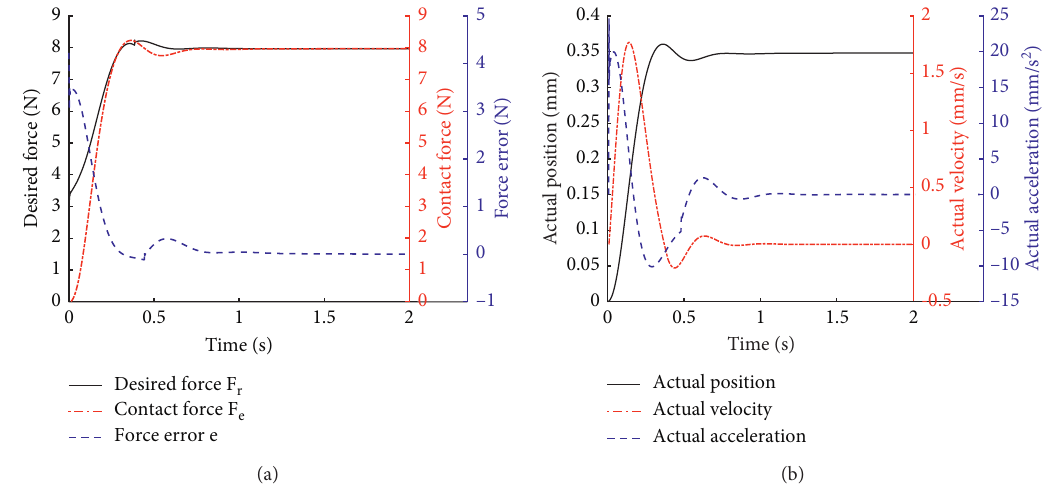
Figure 15: Simulation results of grasping force control with fixed parameter impedance control. (a) Curves of desired force, contact force, and force error varying with time. (b) Curves of actual position, velocity, and acceleration varying with